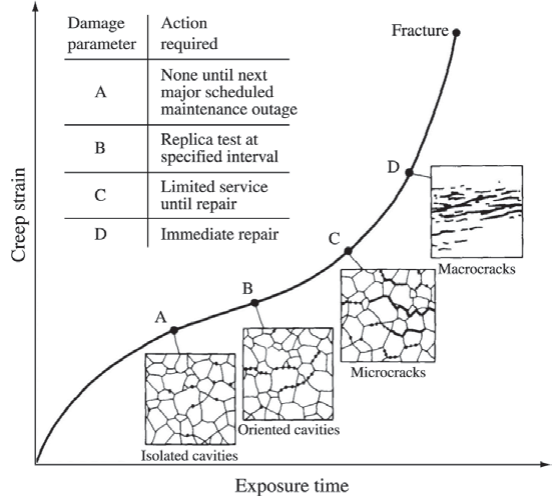
Figure 2. Positions of the samples extracted from a primary su- perheater assembly (dimensions in